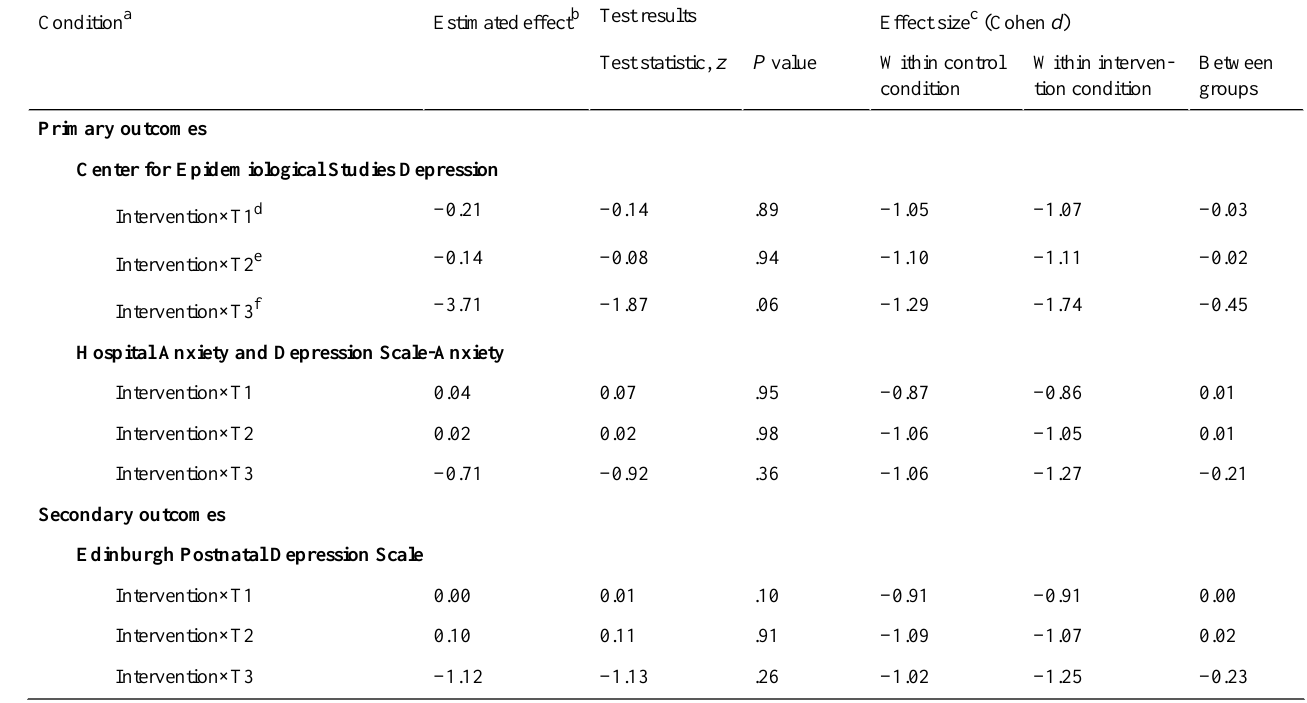
Table 3. Estimated effects (unstandardized), test results, and effect sizes of the differences in primary and secondary outcomes (Center for Epidemiological Studies Depression, Hospital Anxiety and Depression Scale-Anxiety, and Edinburgh Postnatal Depression Scale) within groups and between the intervention group and the control group, using linear mixed model analysis at baseline, 10 weeks after randomization, 4 weeks before expected birth date, and 6 weeks after child birth after correction for scores at baseline.